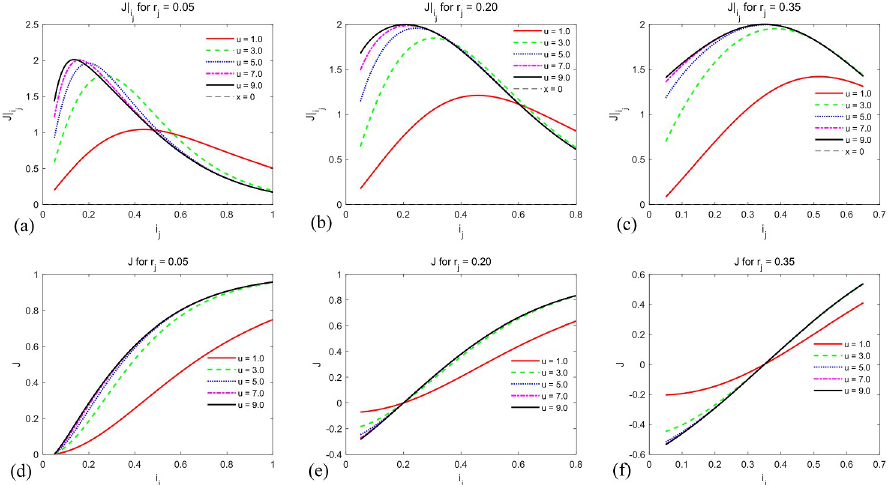
with fixing parameter n = 2. (a)–(c) shows the change of J j i j